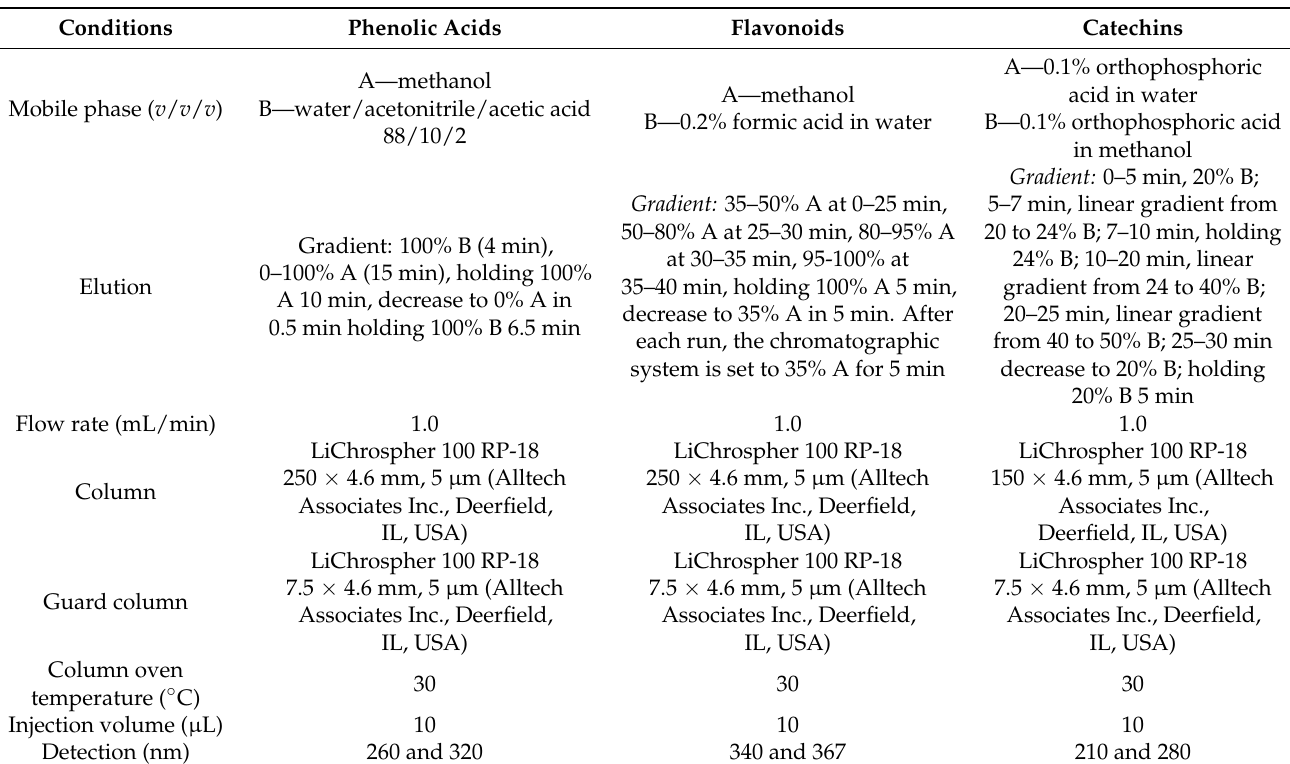
Table 1. High performance liquid chromatography (HPLC) conditions for phenolic com- pound